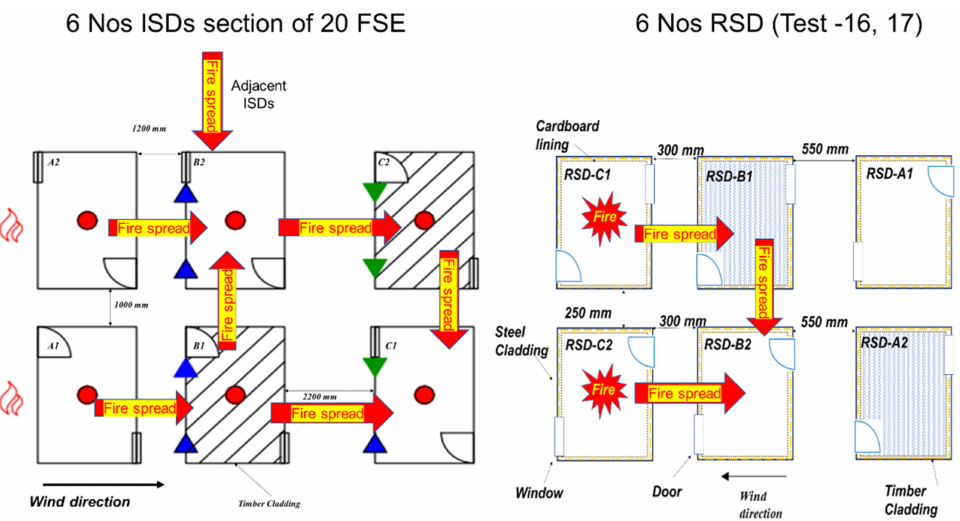
Figure 18. Fire spread in FSEs and 6 Nos RSD test (Test 16 and 17).